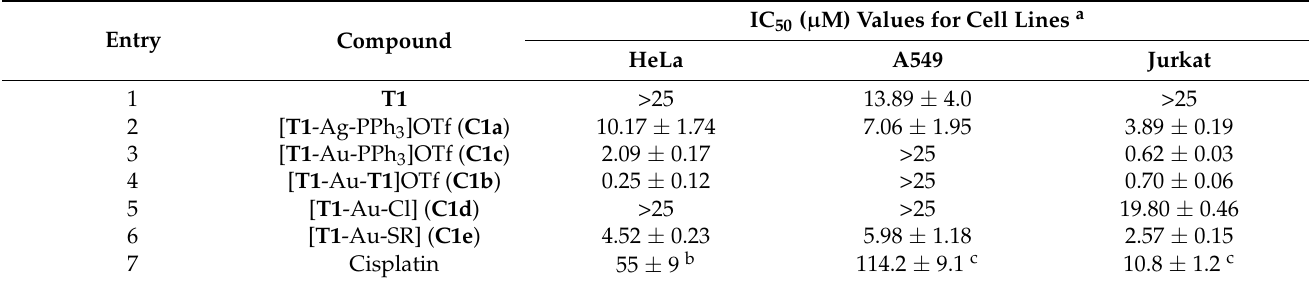
Table 2. Antitumor activity of complexes C1a–e expressed in IC 50 values compared with that of thiourea T1 as reference.